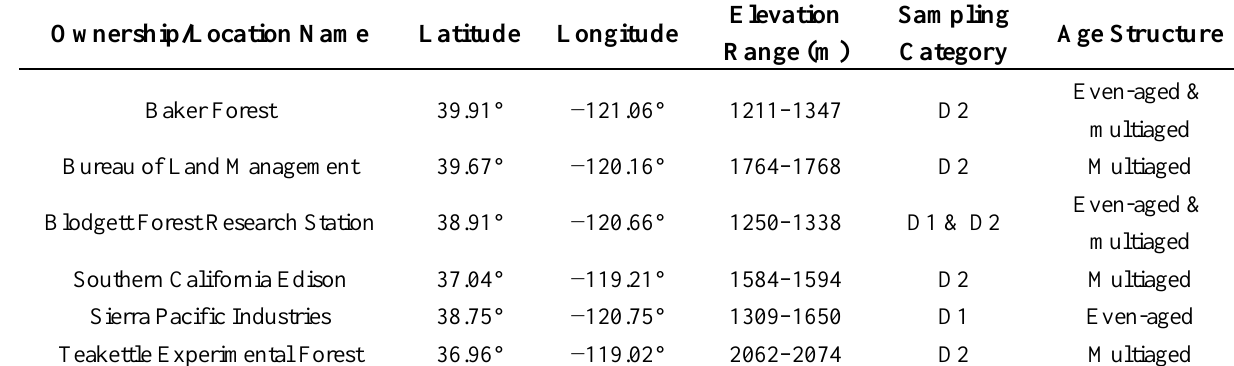
Table 1. Summary information for study sites for each sampling category.